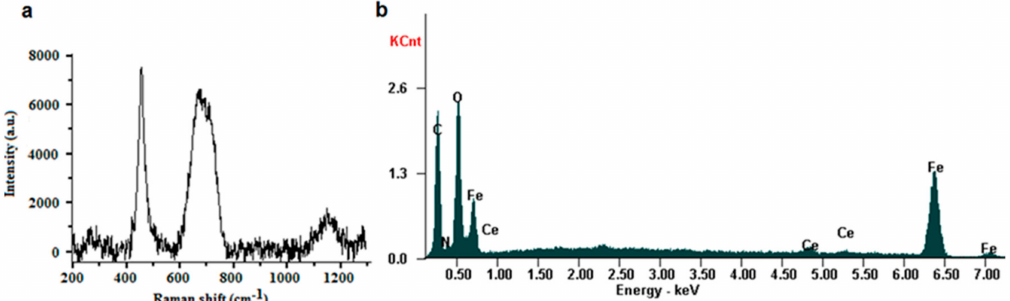
Figure 3. Raman spectra ( a ) and energy-dispersive X-ray spectroscopy (EDX) analysis ( b ) for the MCePEI-GA